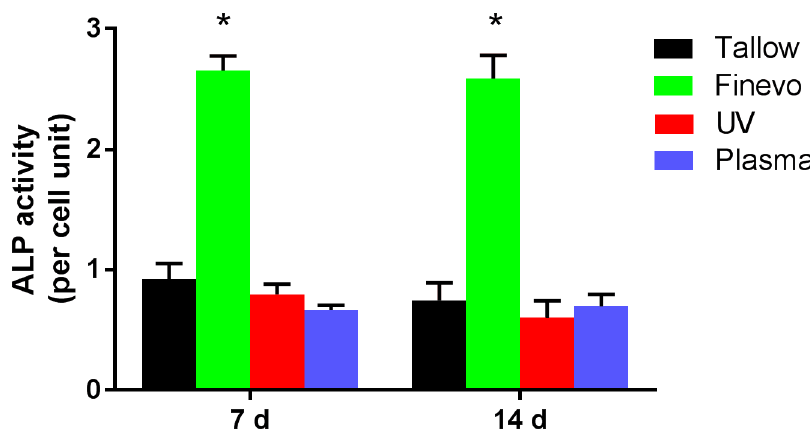
Figure 7. Alkaline phosphatase (ALP) activity of cells on Finevo-Ti was the highest after 7 and 14 days of differentiation. There were significant differences in ALP activity among the different samples at each time point. Cells on the Plasma-Ti and UV-Ti surfaces showed lower ALP activity than those on Tallow-Ti. Black: Tallow-Ti, Green: Finevo-Ti, Red: Plasma-Ti, Blue: UV-Ti. (* p <0.05)